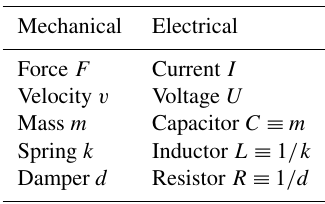
Table 1. Analogies used for the conversion of mechanical systems into an electric circuit.